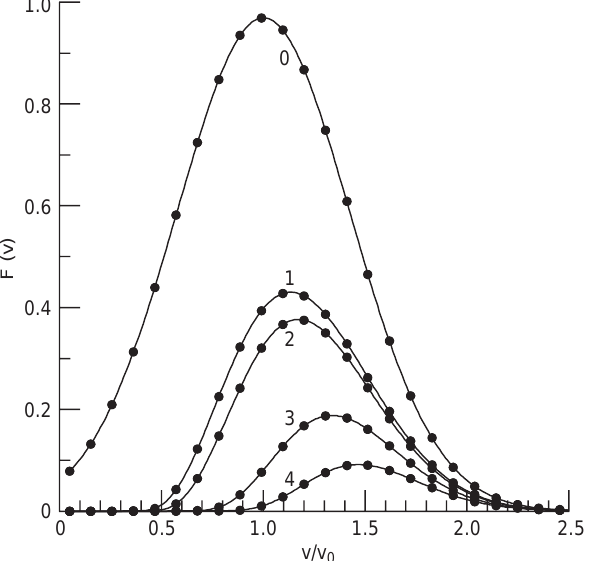
Fig. 2. The transformation of energetic electron distribution over energy F (cid:133) v (cid:134) with increase in u in the weak di(cid:128)usion case at equatorial plane. D v = v 0 (cid:136) 0 : 6 ; mv 2 = 2 (cid:136) 50keV ; l (cid:255) 1 (cid:136) 160 ; D max l (cid:255) 1 (cid:25) 0 : 5 ; 0 c c v